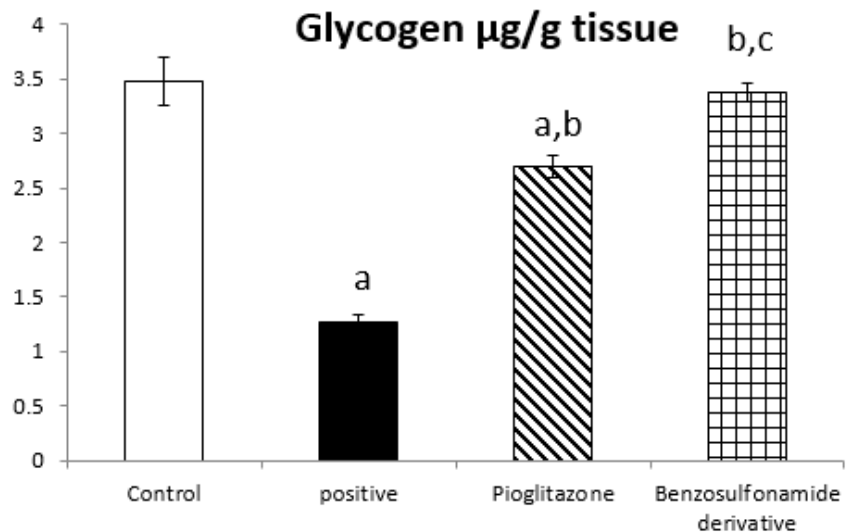
Figure 2. Bar chart presentation of liver tissue ACE 2, Ang (1–7), and glycogen concerning the effect of 14 days of oral administration of the synthetic compound against the reference anti-hyperglycemic pioglitazone on STZ-induced type 2 DM. DM: diabetes mellitus. Each bar represents the mean of 6–8 values ± the standard error of the mean (S.E.M). a: Significantly different from the normal control group, b: Significantly different from the positive control group, c: Significantly different from the pioglitazone group at p < 0.05.